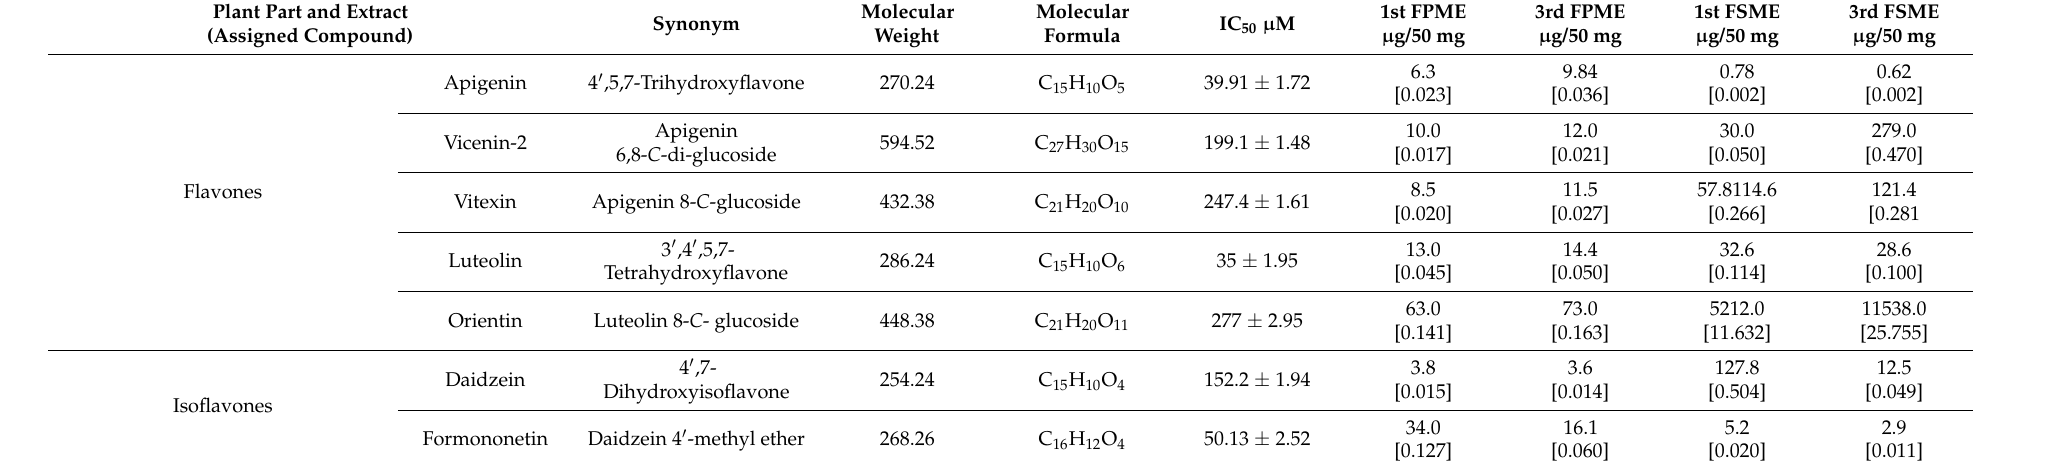
Table 2. Flavonoids quantified in the fenugreek methanol extracts and their IC 50 values when tested individually on MCF-7 cells. Plant Part and Extract (Assigned